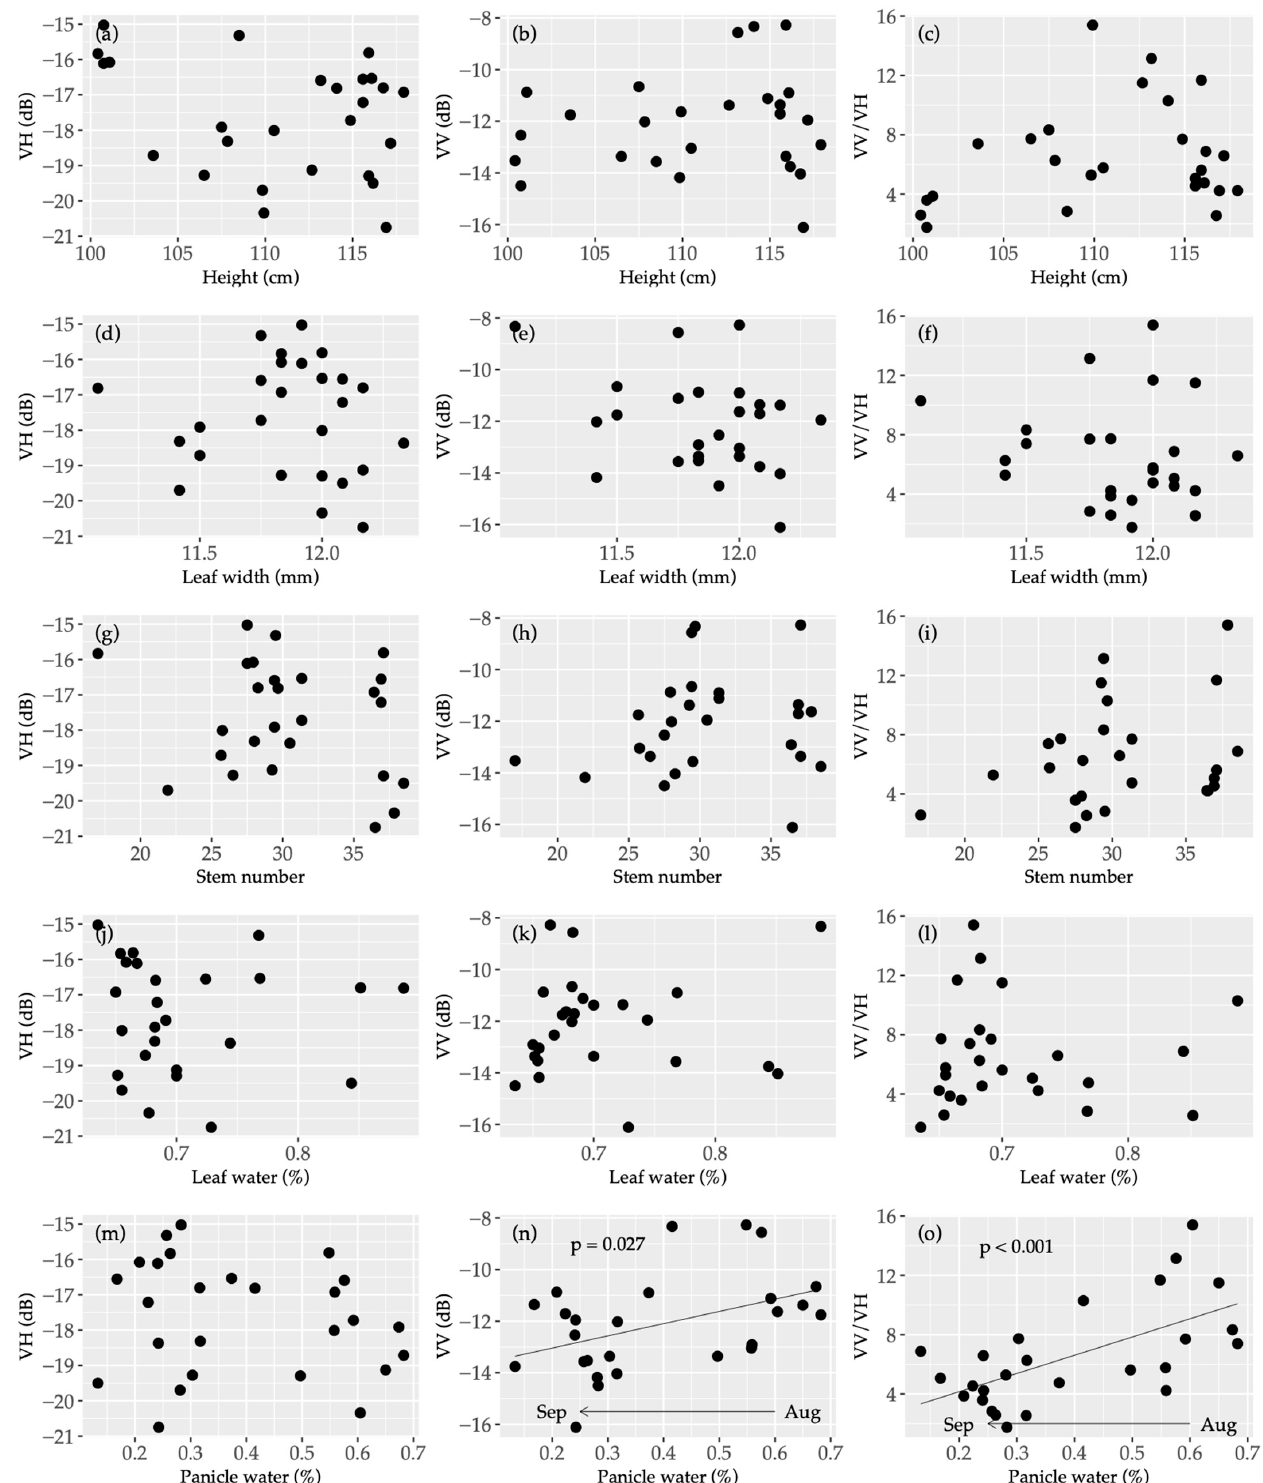
Figure 8. Scatterplots of biophysical parameters during reproduction and ripening periods and microwave backscatter values from orb 39. Plant height (cm), maximum leaf width (mm), stem number, and water content in leaves and panicles (%) are field measurement data. The leftmost column depicts VH, the center shows VV, and the rightmost presents VV/VH. ( a – c ) plant height, ( d – f ) maximum leaf width, ( g – i ) stem number, ( j – l ) leaf water content, and ( m – o ) panicle water content